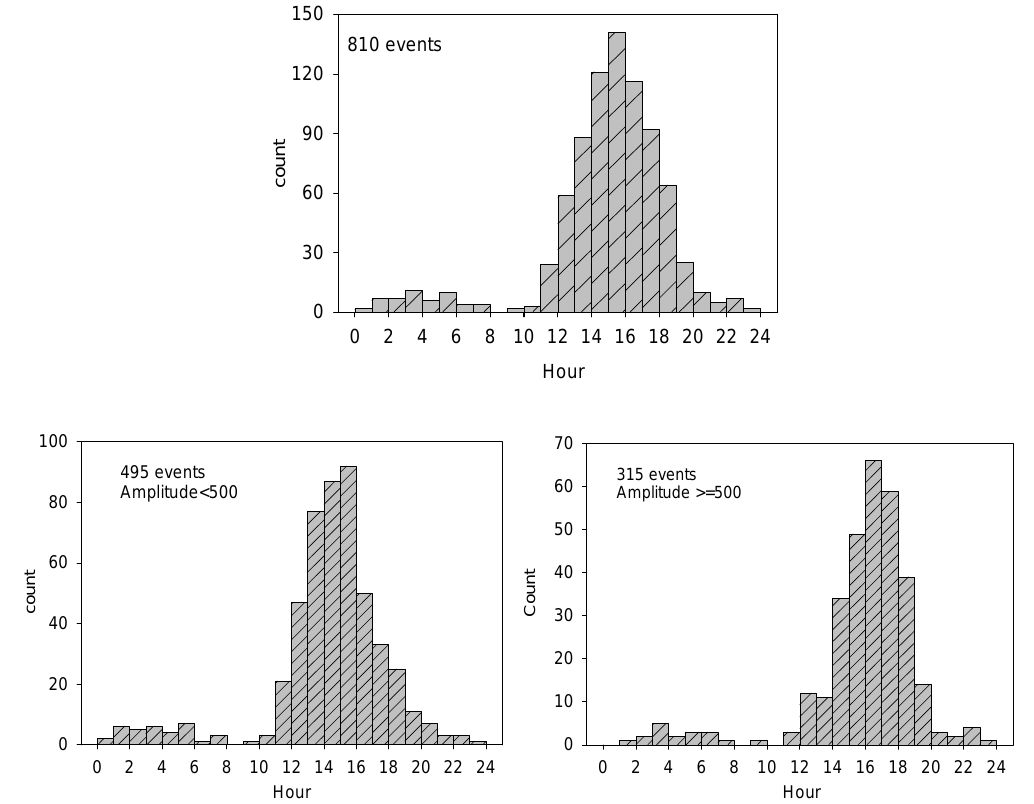
Figure 8: Distribution of peak time of SDR signals within the 24-hour diurnal Fig. 8. Distribution of peak time of SDR signals within the 24-h diurnal cycle (top). SDR peaks tend to occur between 15h00 and 16h:00 cycle (Top). SDR peaks tend to occur between 15 and 16 hours (UT+2). The (UT + 2). The pattern is the same for SDR signals with low and high amplitudes (bottom). pattern is the same for SDR signals with low and high amplitudes (Bottom). n= 875 (asymmetry > -.25)